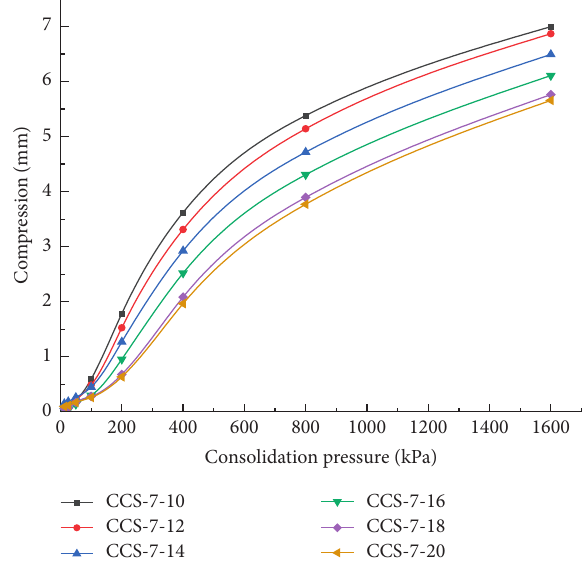
Figure 2: The compression amount-consolidation pressure curves of CCS-7.